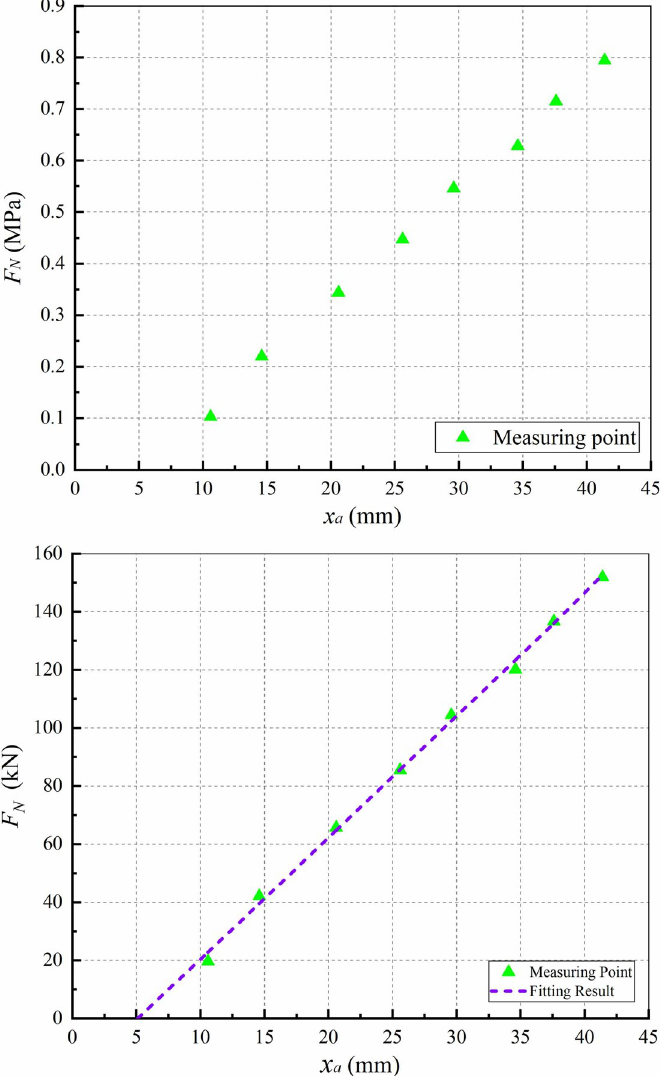
Fig 2. Caliper model. (a) The caliper characteristics provided by the manufacturer; (b) The fitted caliper model after unit